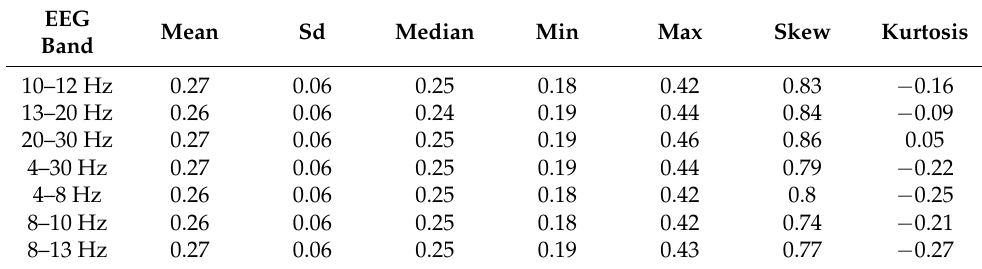
Table 2. Descriptive statistics of characteristic path length metric for narrow EEG bands.